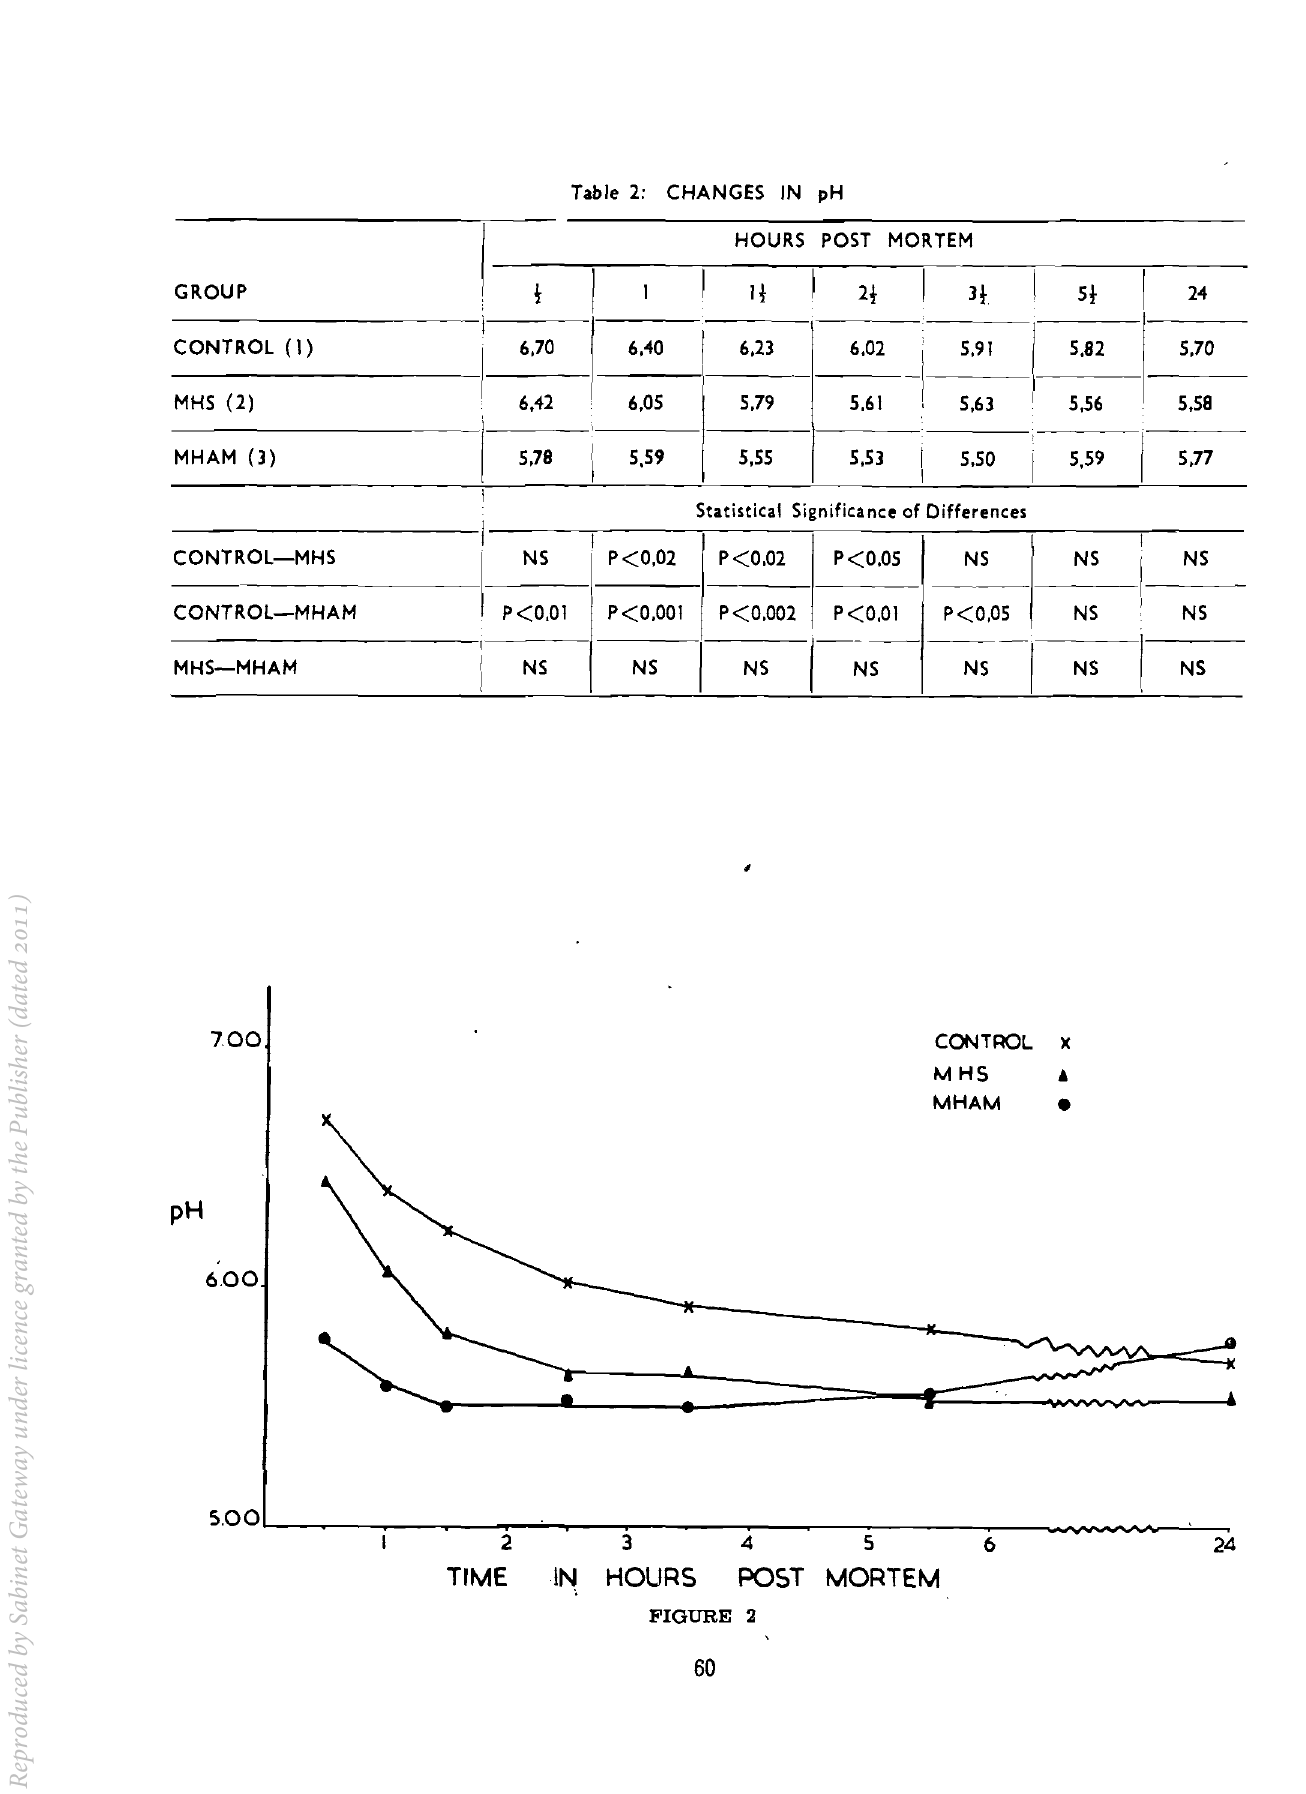
Table 2: CHANGES IN